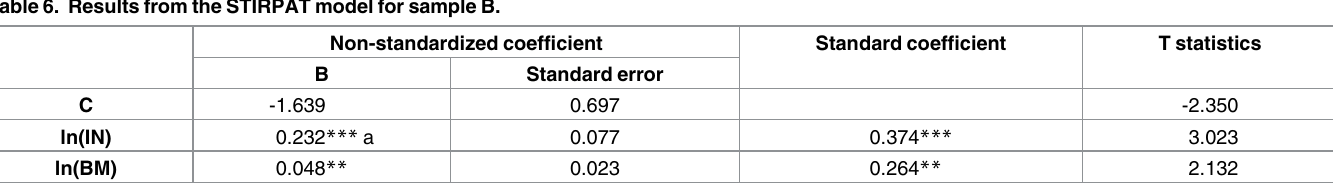
Table 6. Results from the STIRPAT model for sample